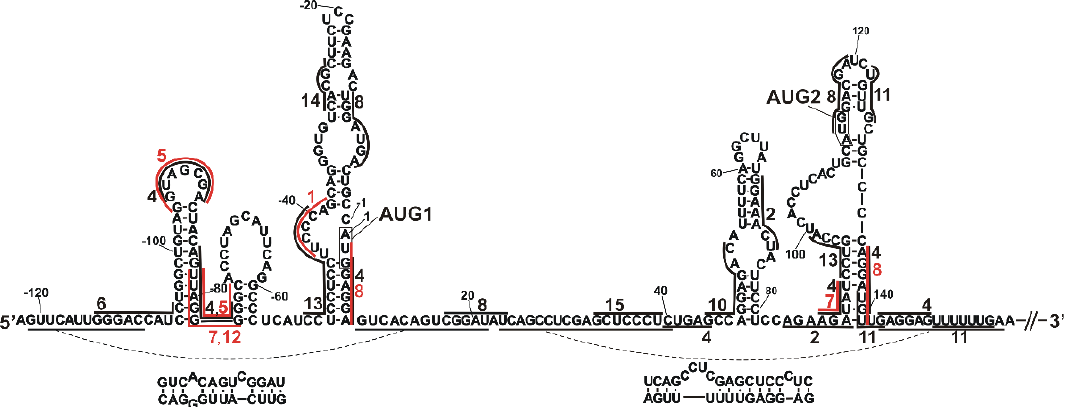
Figure 6. The predicted binding sites for selected protein candidates marked on the secondary structure model of the 5′ -terminal region of p53 mRNA. The binding sites are marked with black and red lines along the sequence; red color lines are used to better visualize binding sites in regions where several proteins bind. Binding sites for selected proteins listed in Table 2 were determined based on the RBPmap and ATtRACT databases and on literature information.